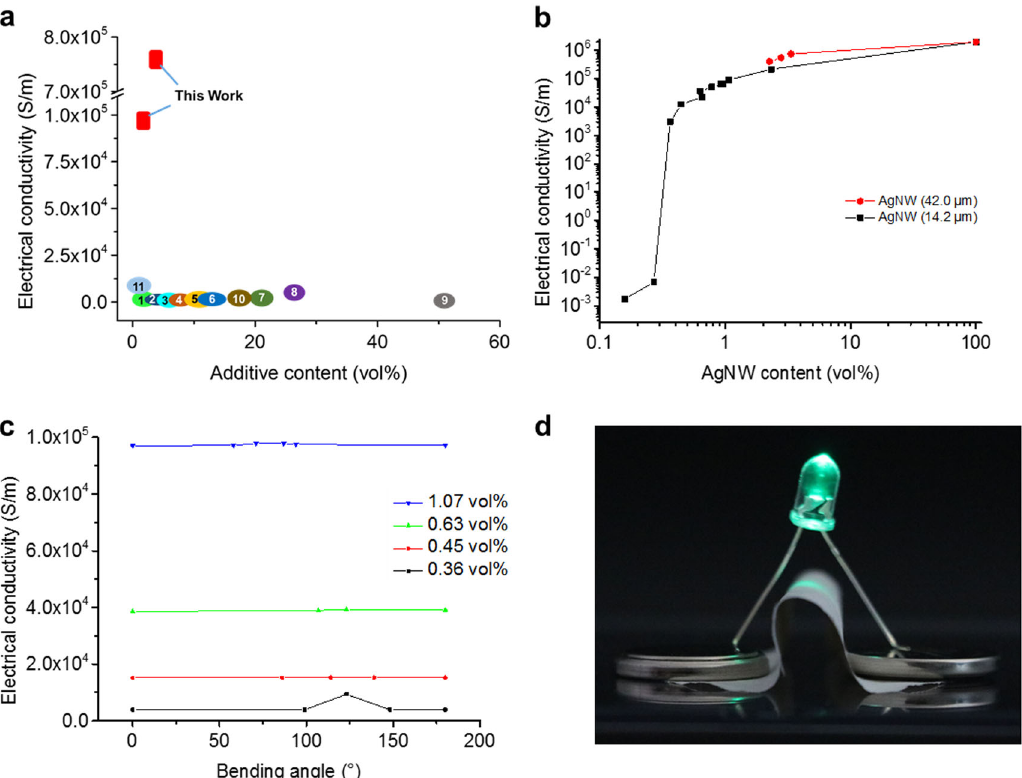
Fig. 2 Electrical properties of conductive nonwovens. a Ashby plot showing the electrical conductivity of different conductive composite nonwovens against their conductive additive content: 1 carbon nanotube/polylactide(PLA) fi bres 42 ; 2 carbon black/PLA fi bres 42 ; 3 PANI/ natural rubber fi bres 43 ; 4 PANI-dodecylbenzene sulphonic acid/Co-PAN fi bres 44 ; 5 carbon nanotube/PET fi bres 45 ; 6 PANI/bacterial cellulose fi bres 46 ; 7 poly(3,4-ethylenedioxythiophene):polystyrene sulphonate (PEDOT:PSS/PNN) fi bres 47 ; 8 PEDOT:PSS/hollow carbon fi bres 48 ; 9 PANI/ polystyrene fi bres 49 ; 10 MWNT/cellulose fi bres 50 ; 11 AgNW/cellulose fi bres. 51 b Electrical conductivity with respect to the AgNW content. c Electrical conductivity dependence on bending angle. d Photograph of an LED operated by two coin batteries connected by a fl exible conductive PAN/PCL nonwoven with 1.07 vol%